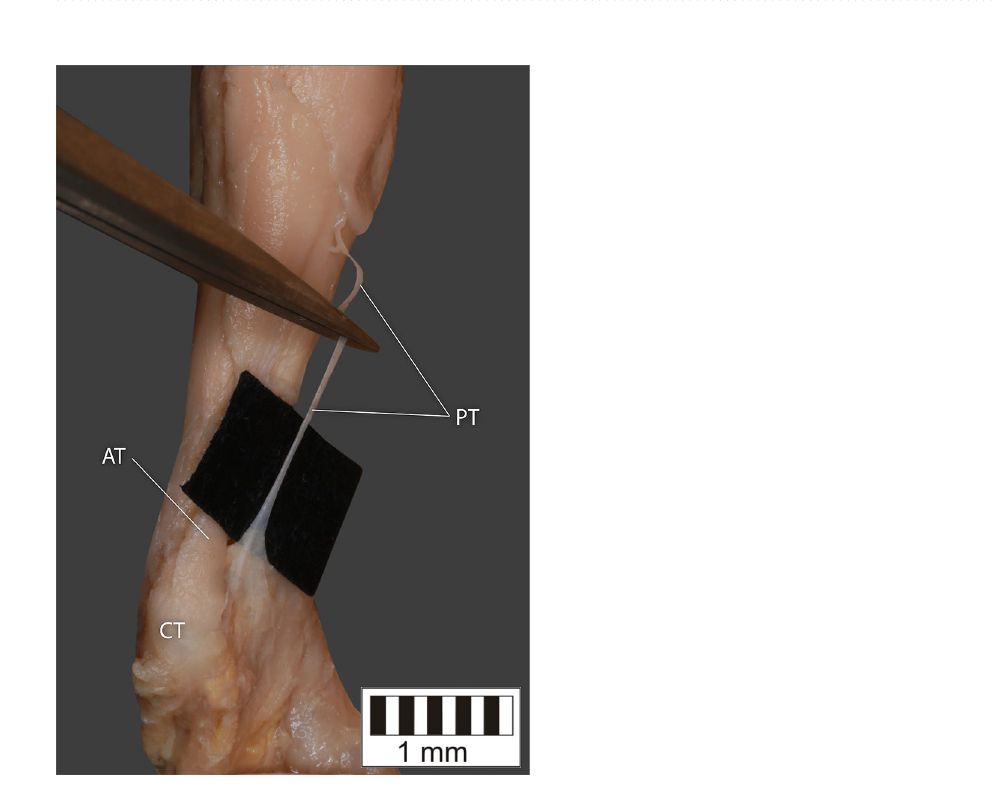
Figure 8. Type VI of plantaris tendon. CT calcaneal tuberostity, AT Achilles tendon, PT plantaris